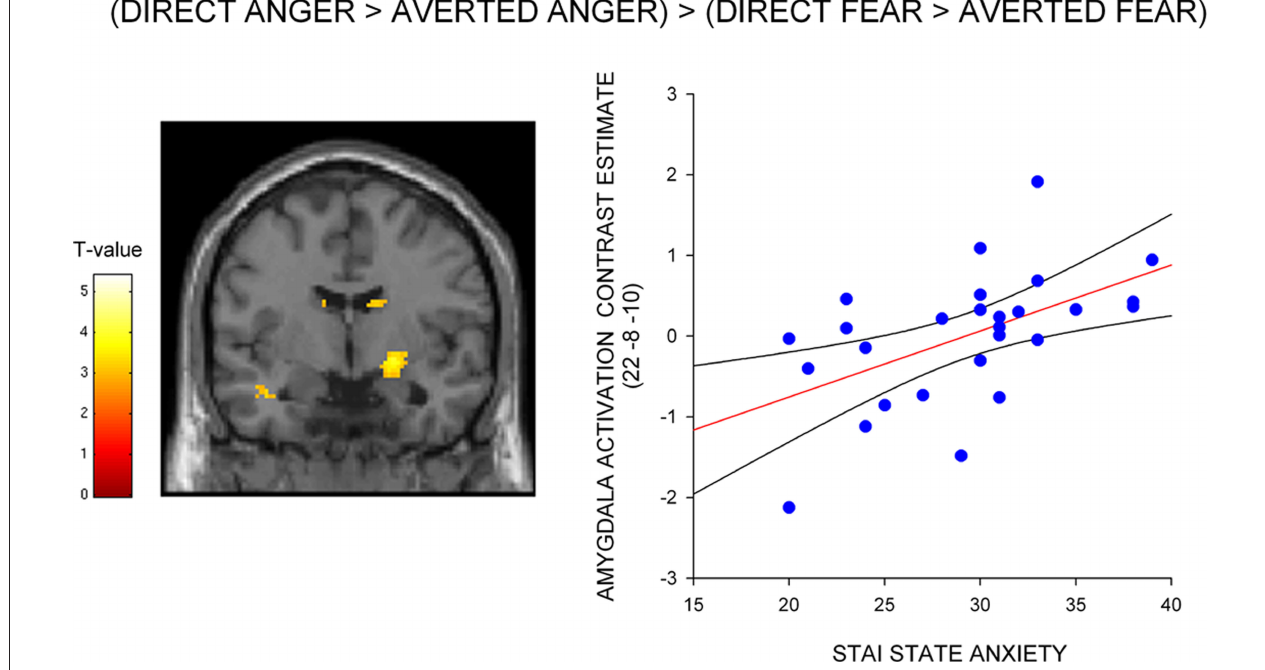
contrast estimates of activation in the peak voxel of an anatomically defined amygdala ROI plotted against individual measures of state anxiety, included for illustration purposes only. Activation maps are thresholded at P < 0.005 uncorrected (10 contiguous voxels) for display